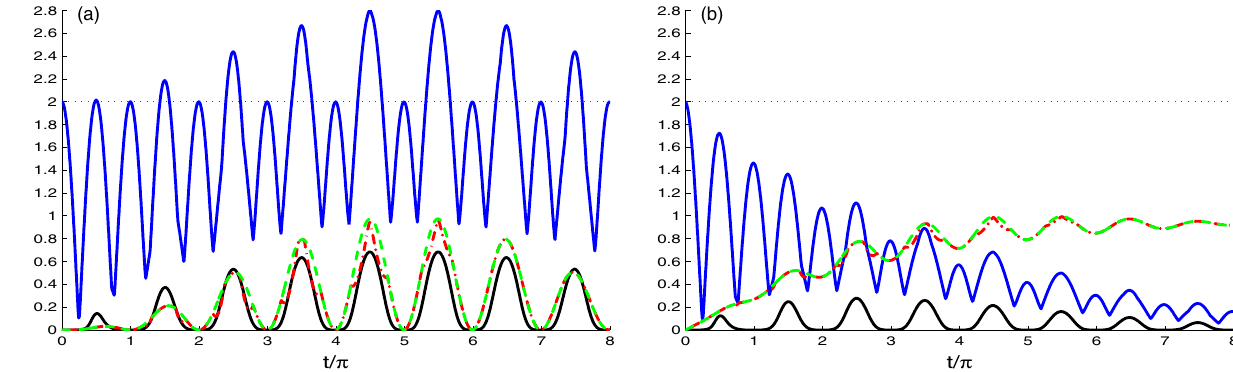
Figure 1. Time evolution of L ( t ) (dashed plots), U ( t ) (dashed dotted plots), M ( t ) (upper solid plots) and N ( t ) (solid plots) for large coupling case J the NVD are prepared initially in uncorrelated state,